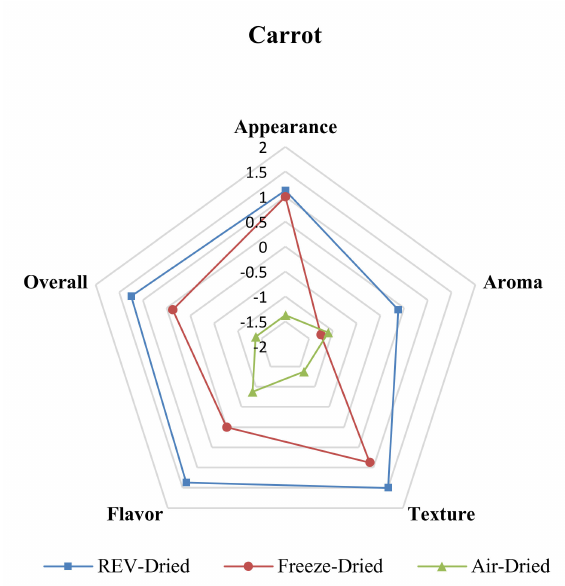
Figure 4. Cobweb diagram of five sensory attributes of REV-Dried, freeze-Dried, and air-Dried products based on panelists (cid:48) rating.